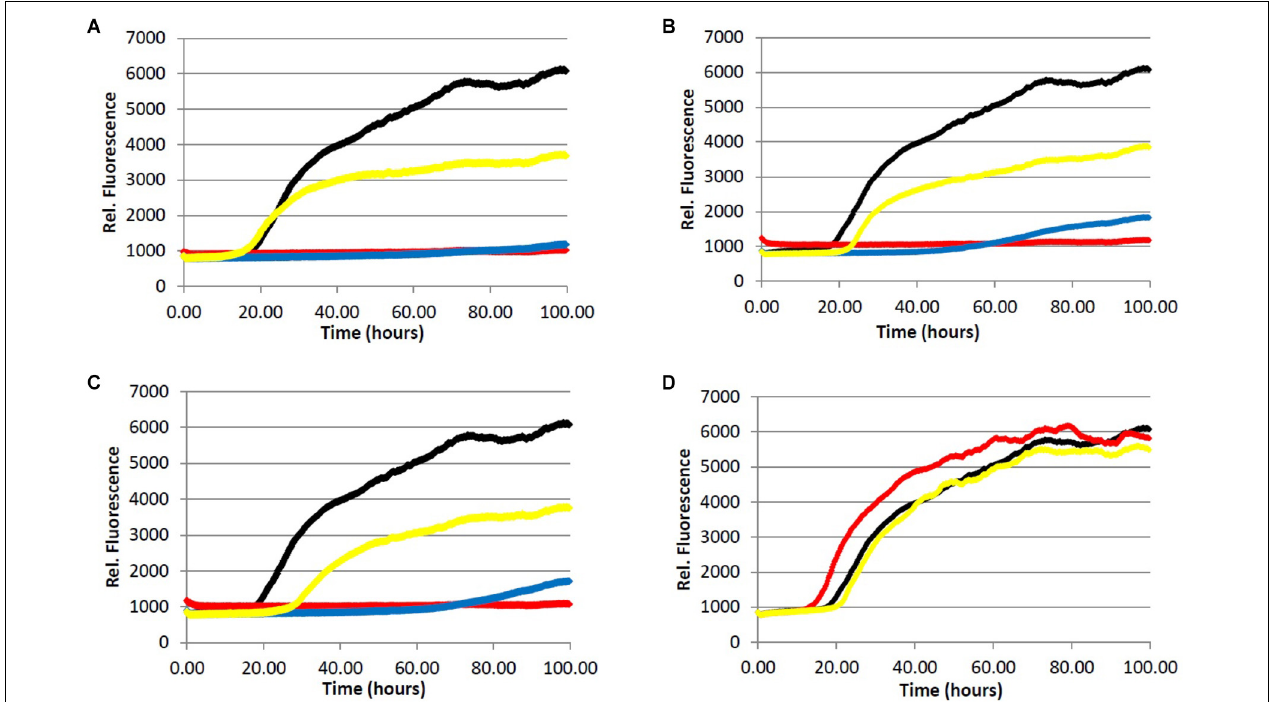
FIGURE 2 | Fibrillization of A β peptide. 20.0 µ M A β 1 − 40 in Tris buffer (20.0 mM, pH 7.4, 150 mM NaCl) was incubated at 37.0 ◦ C in the presence of 4.0 µ M ThT and variable concentration of analyte. (red) = 200 µ g/mL, (blue) = 40.0 µ g/mL, (yellow) = 5.0 µ g/mL, (black) = 0.0 µ g/mL (vehicle control). (A) Light roast instant